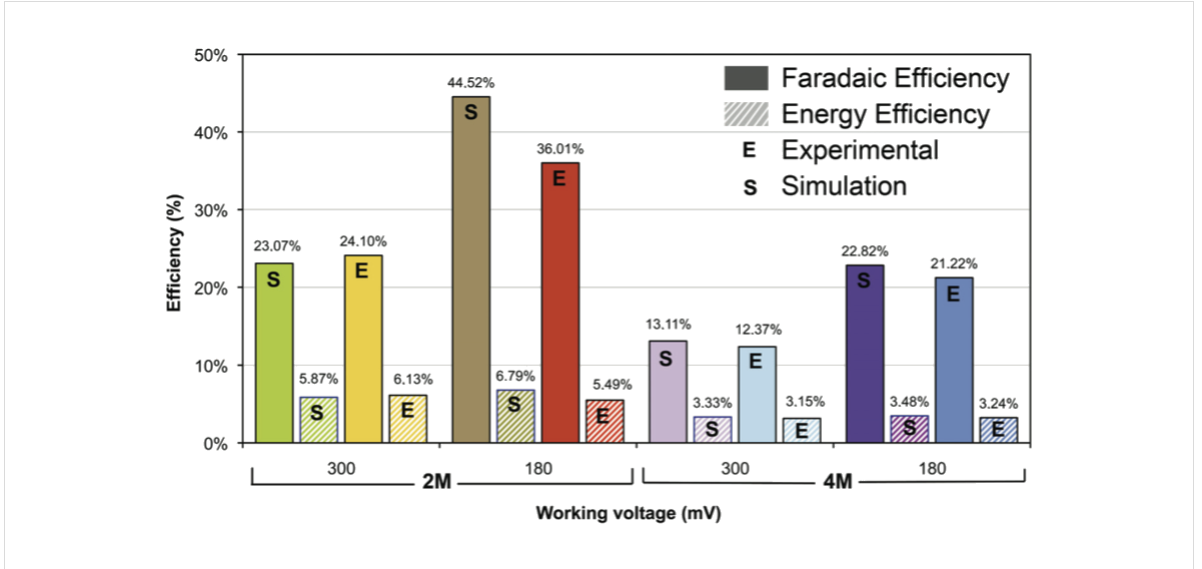
Figure 4: Comparison between experimental and modelled faradaic efficiency and energy efficiency of the micro-fuel cell fuel at different concentra- tions and operating